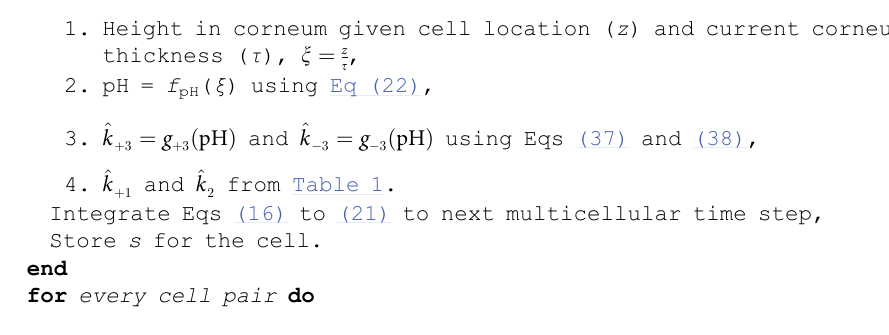
Algorithm 1 : Linking the subcellular model to cell-cell adhesion in the multicellular model for each multicellular model time step